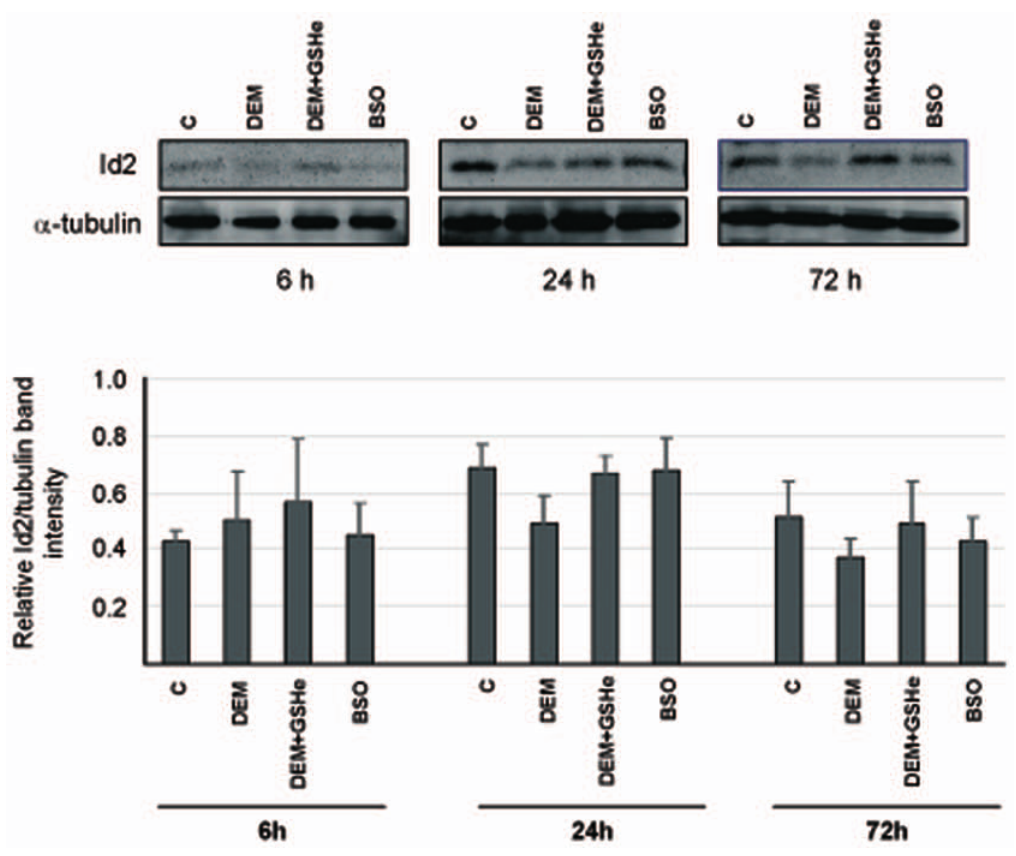
Figure 7. The expression of the cell proliferation marker, Id2, after the depletion of the GSH. The cells were plated as usual and after attaching, 100 m M DEM, or 10 mM BSO, or 100 m M DEM + 1 mM GSHe were added. The protein extracts were obtained at 6 h, 24 h, and 72 h of culture and western blotting was performed as described in materials and methods. At upper panel, western blot analysis of Id2 and b -tubulin in 3T3 fibroblasts at 6, 24, and 72 h of culture is shown. Lower panel shows the relative Id2 to b -tubulin band intensity [Mean 6 SD (n=4)] derived from densitometry.